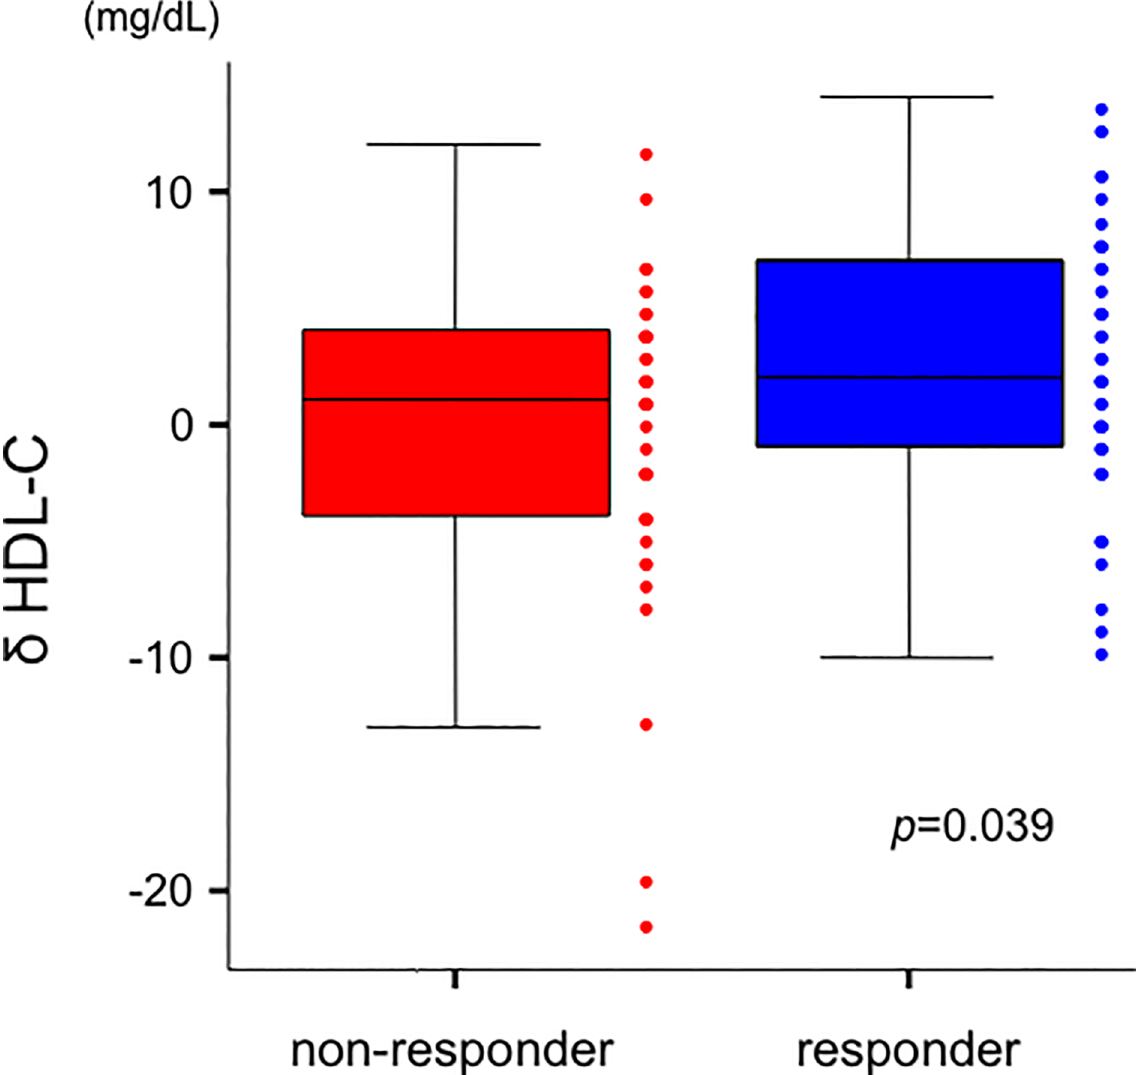
Fig 3. Comparison of δ HDL-C levels between the 2 groups. δ HDL-C levels in patients with responder group were greater than those in non-responder group (responder: 2.5 ± 5.9 mg/dL vs. non-responder: − 0.3 ± 6.7 mg/dL, p = 0.039). Data are presented as box and whisker plots with median and 25th to 75th percentiles (boxes) and 10th to 90th percentiles (whiskers). HDL-C = high-density lipoprotein cholesterol.